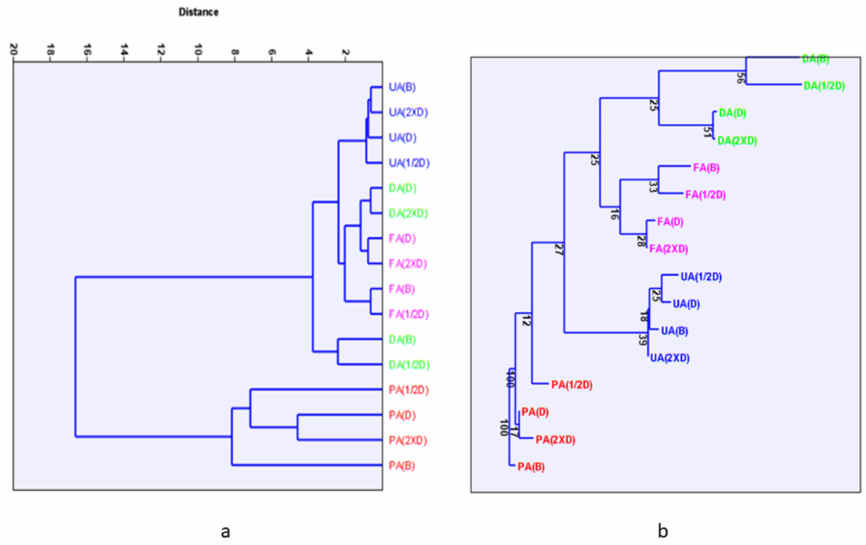
Figure 2. Cluster analysis based on Euclidian distances ( a ) and the Neighbor Joining Cluster ( b